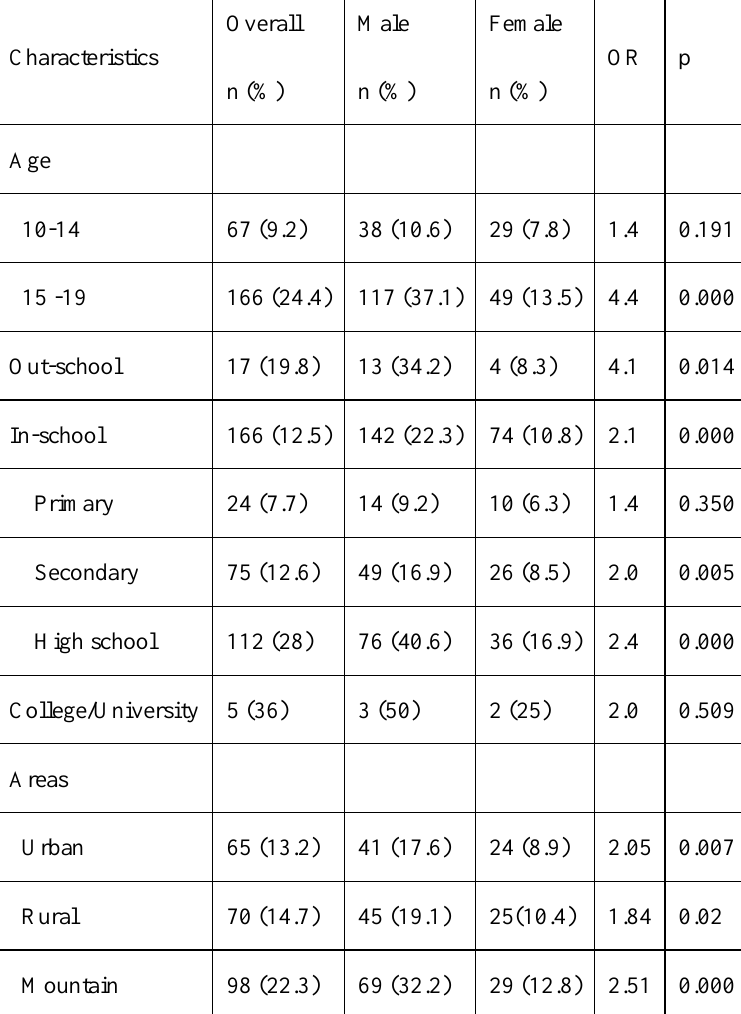
Table 3: Alcohol consumption and demographic factors